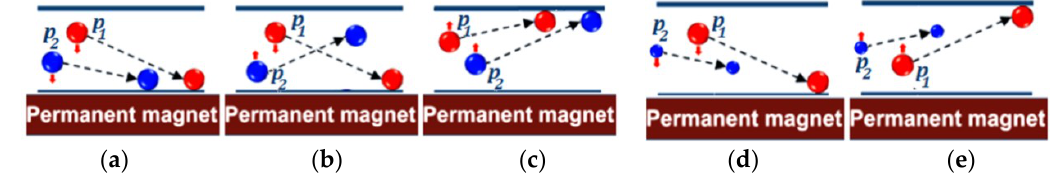
Figure 1. Schematic of particle separation by magnetophoresis. ( a ) M